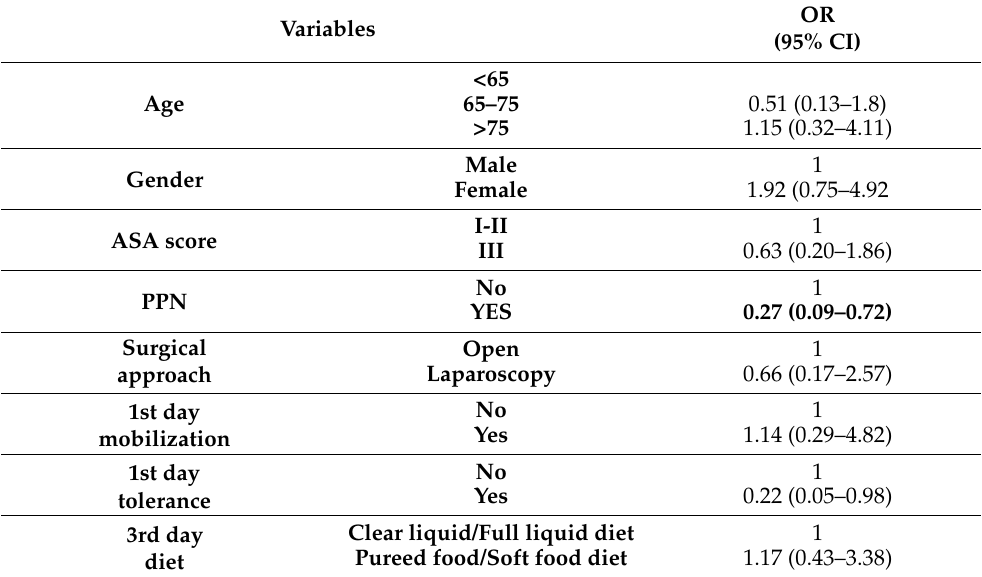
Table 5. Multivariate ordinal logistic regression for complication response variable taking account the order for non-complication vs. minor vs. major complications. Proportional odds ratios are